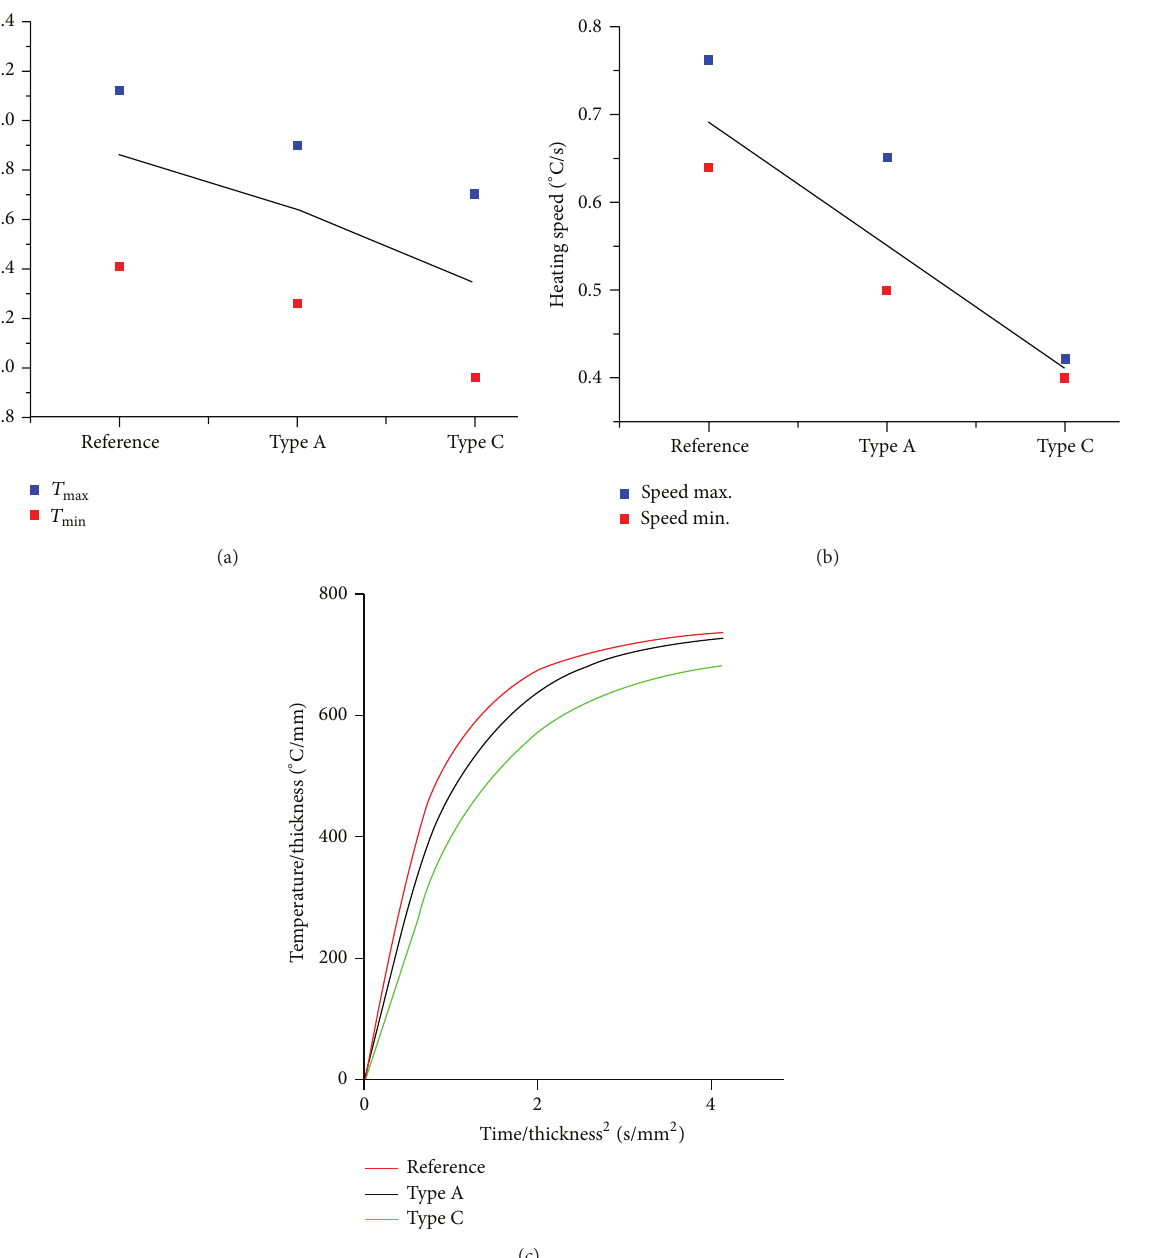
Figure 12: Analysis of the coating properties through IR